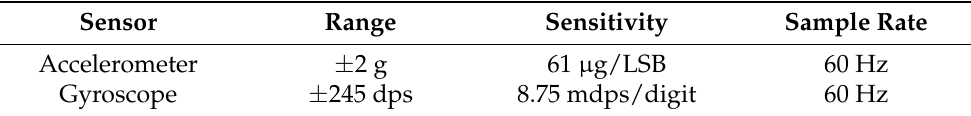
Table 3. Inertial sensors technical characteristics.